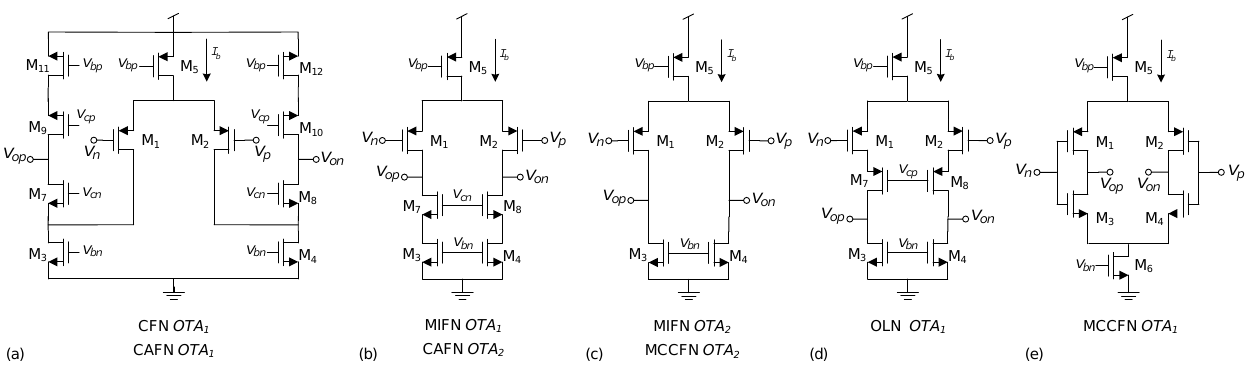
Figure 3. Transistor-level OTA implementation for: ( a ) OT A